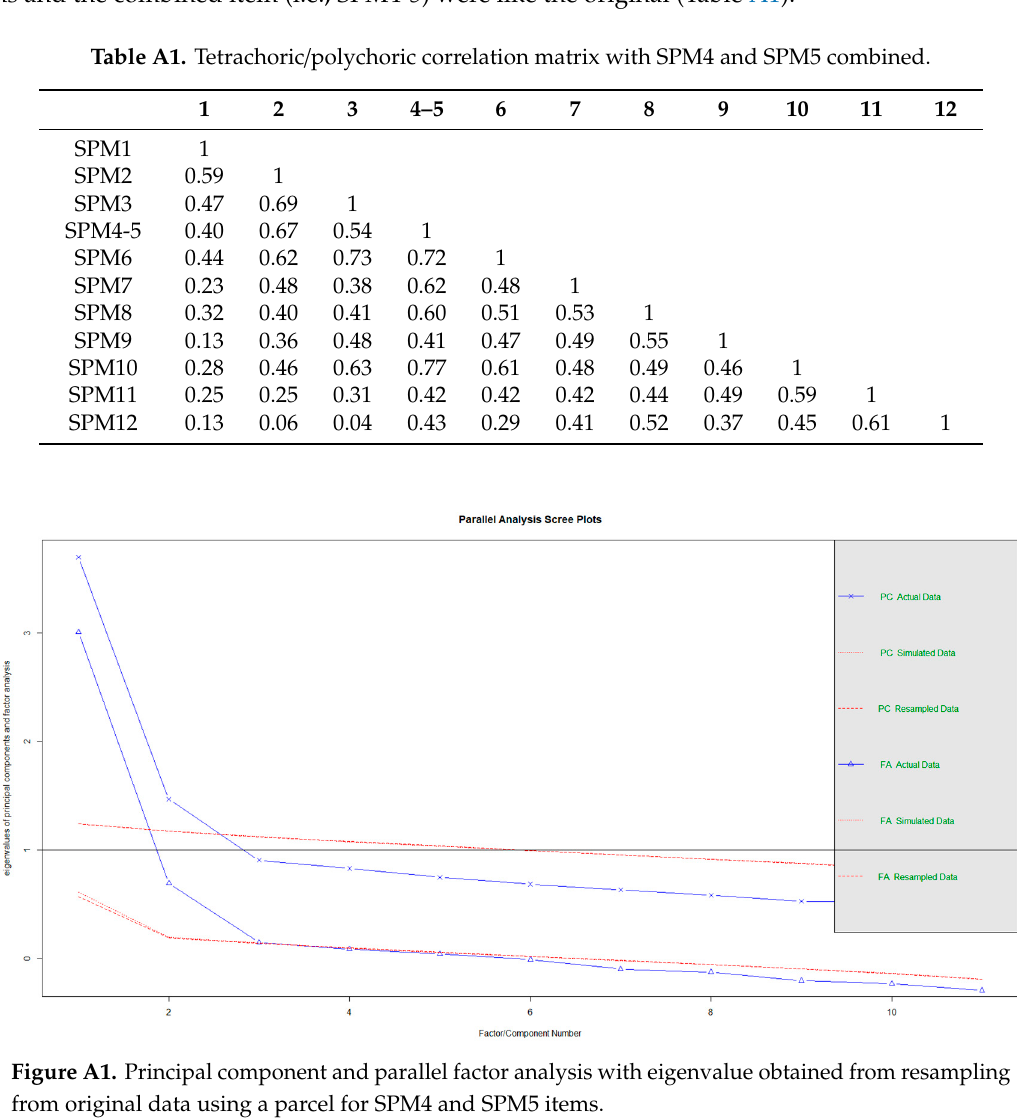
Figure A2. Exploratory Graph Analysis of SPM-LS data with SPM4 and SPM5 item combined. Dimensions and items associated are presented in different colours. Positive partial correlations are depicted in green, with negative partial correlations presented in red. The size of the lines indicates the size of the partial correlations. SPM4 = SPM4-5 item. Lastly, and in the case to be of interest, standardised factor loadings and model fit indices are provided. Noteworthy, results were similar to other models presented in this article but provided a sustainably worse fit to the data. In the exploratory models, SPM4-5 showed lower factor loadings in the S1 (model BID.EFA) or G (model BEFA), and higher cross-loadings on the alternative factors. In